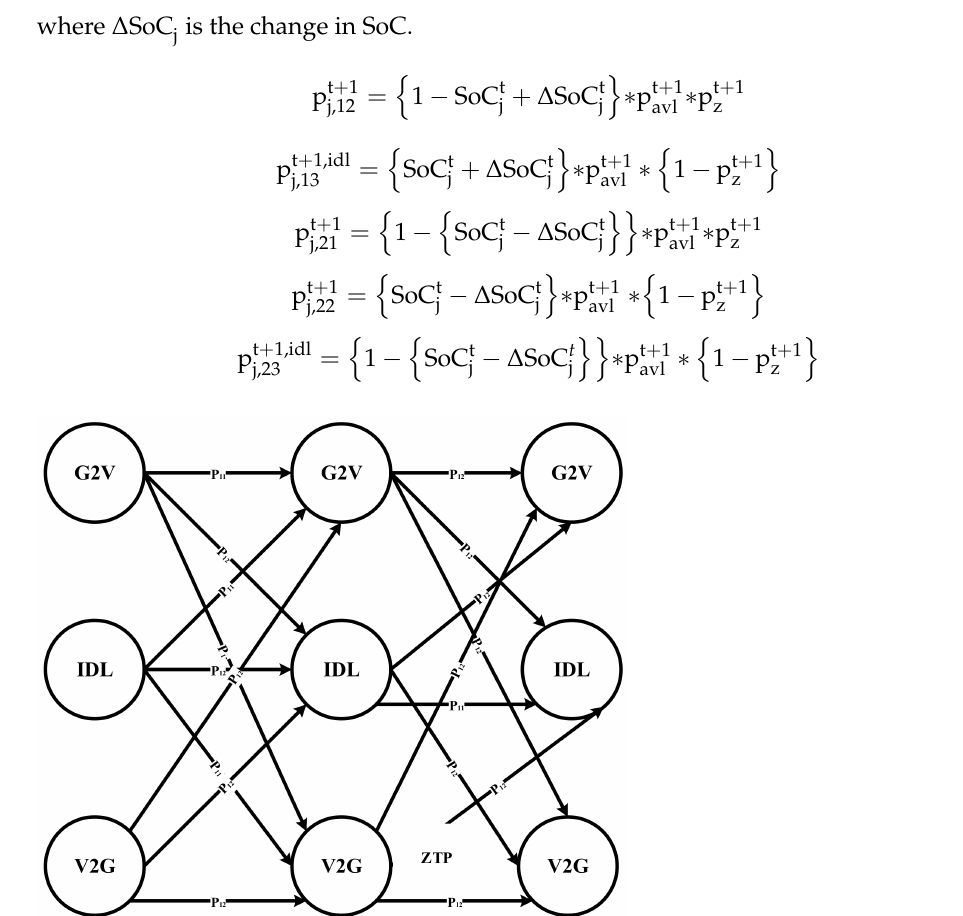
Figure 5. S.T.P.s of the EVs for the next possible